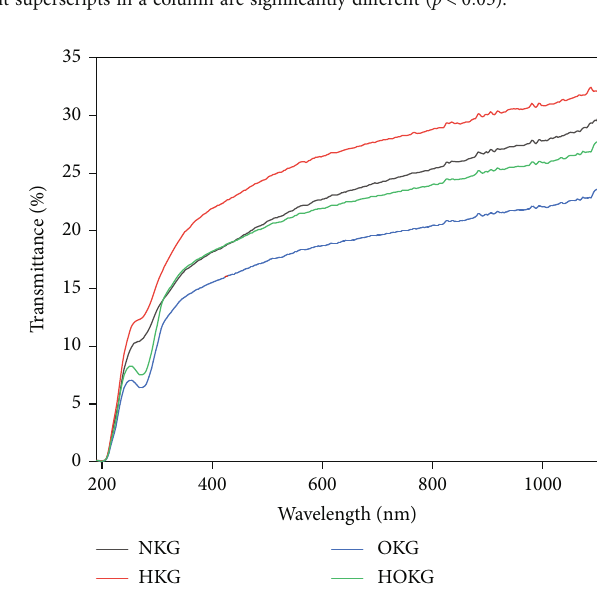
Table 3: Results of moisture, water uptake, solubility, and moisture permeability of the fi lms. Starch fi lm with